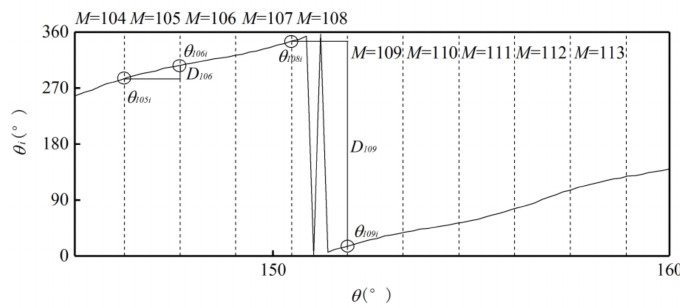
Figure 7. Partial curve with